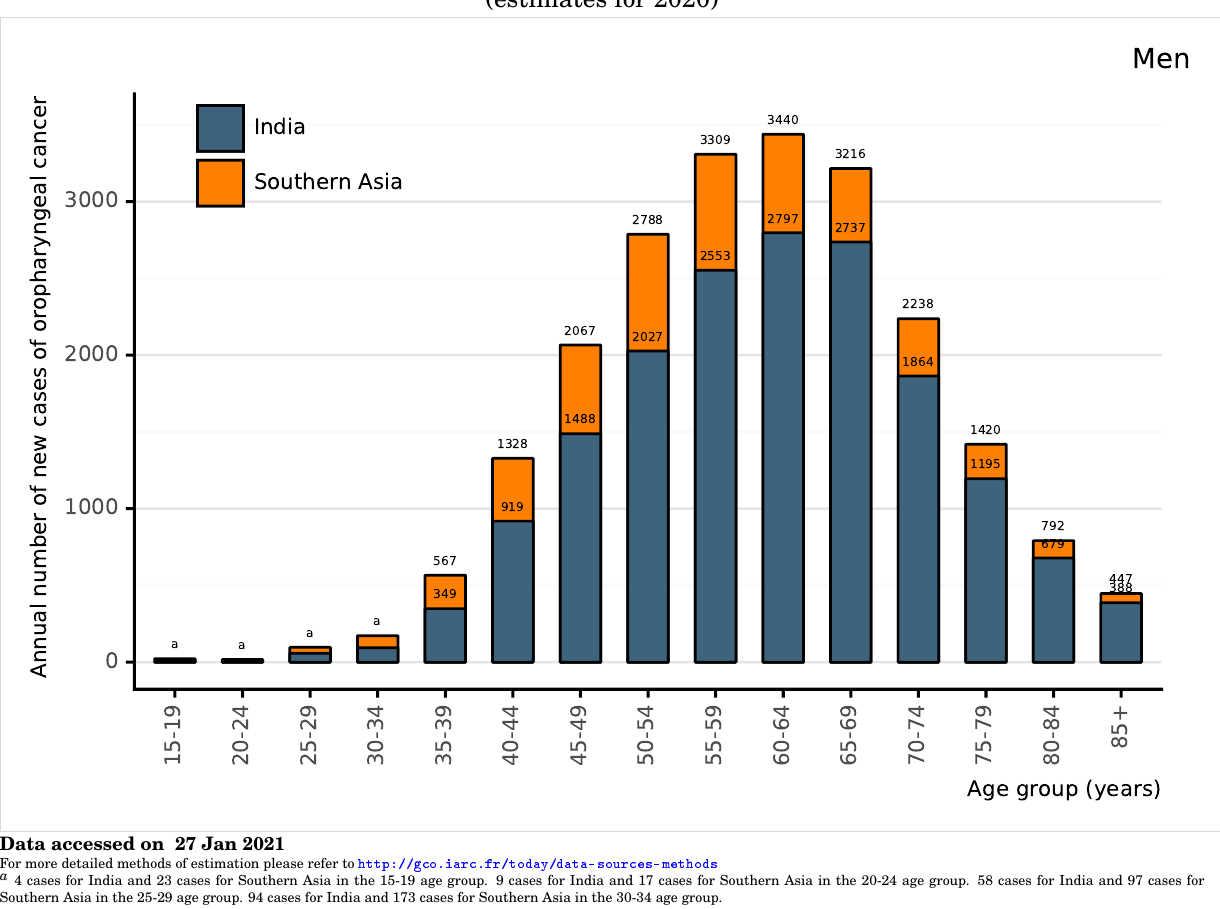
Figure 91: Annual number of new cases of oropharyngeal cancer among men by age group in